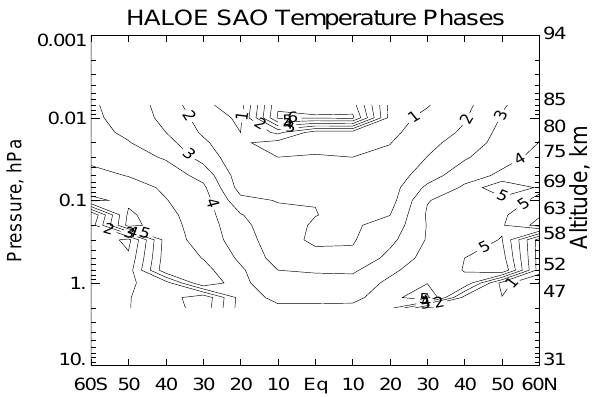
Fig. 5. As in Fig. 4, but for the phase of the annual oscillation (AO) term. Contour interval is 2